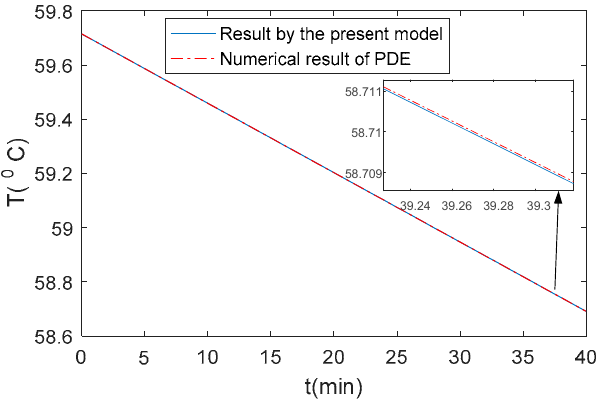
Table 1. Heat pipeline parameters [4,25].